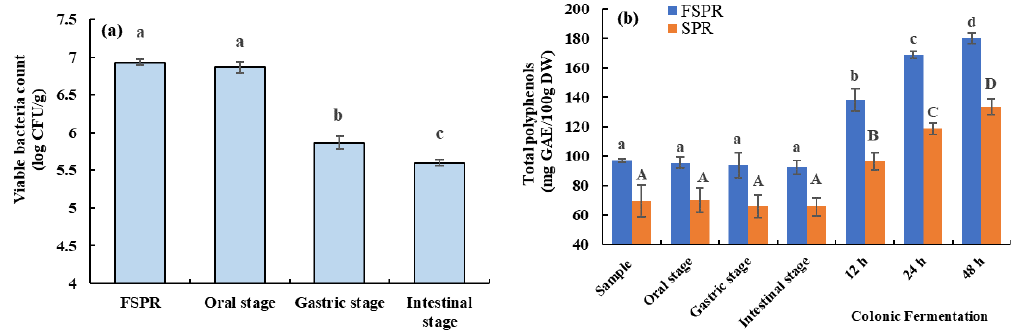
Figure 3. Viable bacteria counts ( a ) and total polyphenol contents ( b ) during in vitro digestion and colonic fermentation; Uppercase letters: Significantly different ( p < 0.05) by Duncan’s test of SPR (Sweet potato residues) group; Lowercase letters: Significantly different ( p < 0.05) by Duncan’s test of FSPR (Sweet potato residues fermented under optimal process)